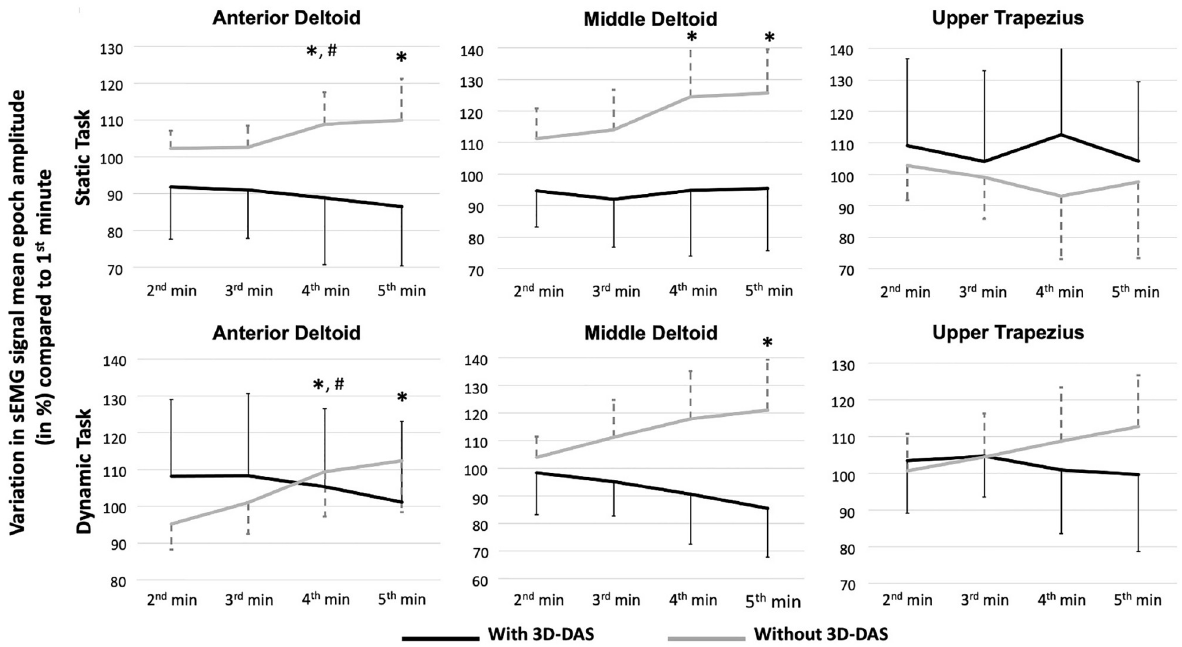
Fig 3. Mean variation in EMG signal mean epoch amplitude (in %; with standard deviation) compared to the first minute during the tasks with and without the dynamic arm support (3D-DAS) (n = 15 for each task). Significantly different (P < 0.05/7 or < 0.007 [Bonferroni adjustment]) compared to � the 1 st minute or to # the previous minute when the task was performed without the